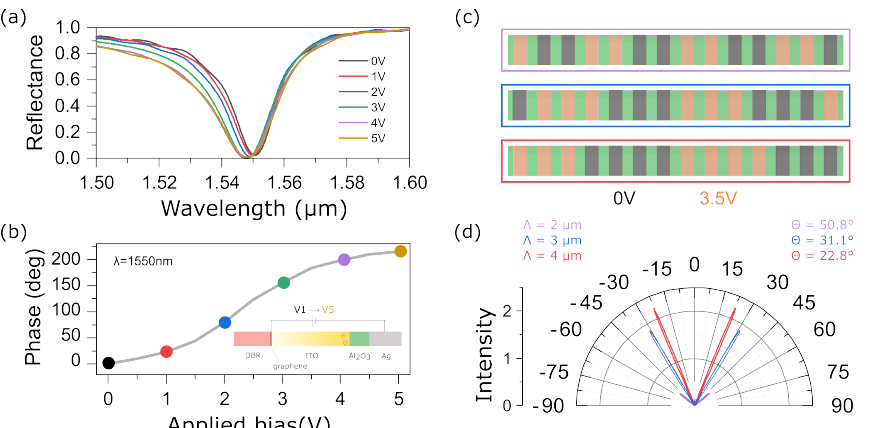
Figure 2. ( a , b ) Reflectance spectra of the structure presented in Figure 1a,b simulated phase shift as a function of applied bias voltage between Ag nanostripes and monolayer graphene; ( c ) schematic of the diffraction grating for a different number of nanostrip pairs; dark gray and orange nanostrips depict nanostrips without bias voltage and with bias voltage of 3.5 V, respectively; an increase in the number of nanostripes with bias voltage and without it leads to an increase in the grating period; ( d ) Simulated far-field reflected intensity from the metagrating as a function of the diffraction angles for a different grating period.